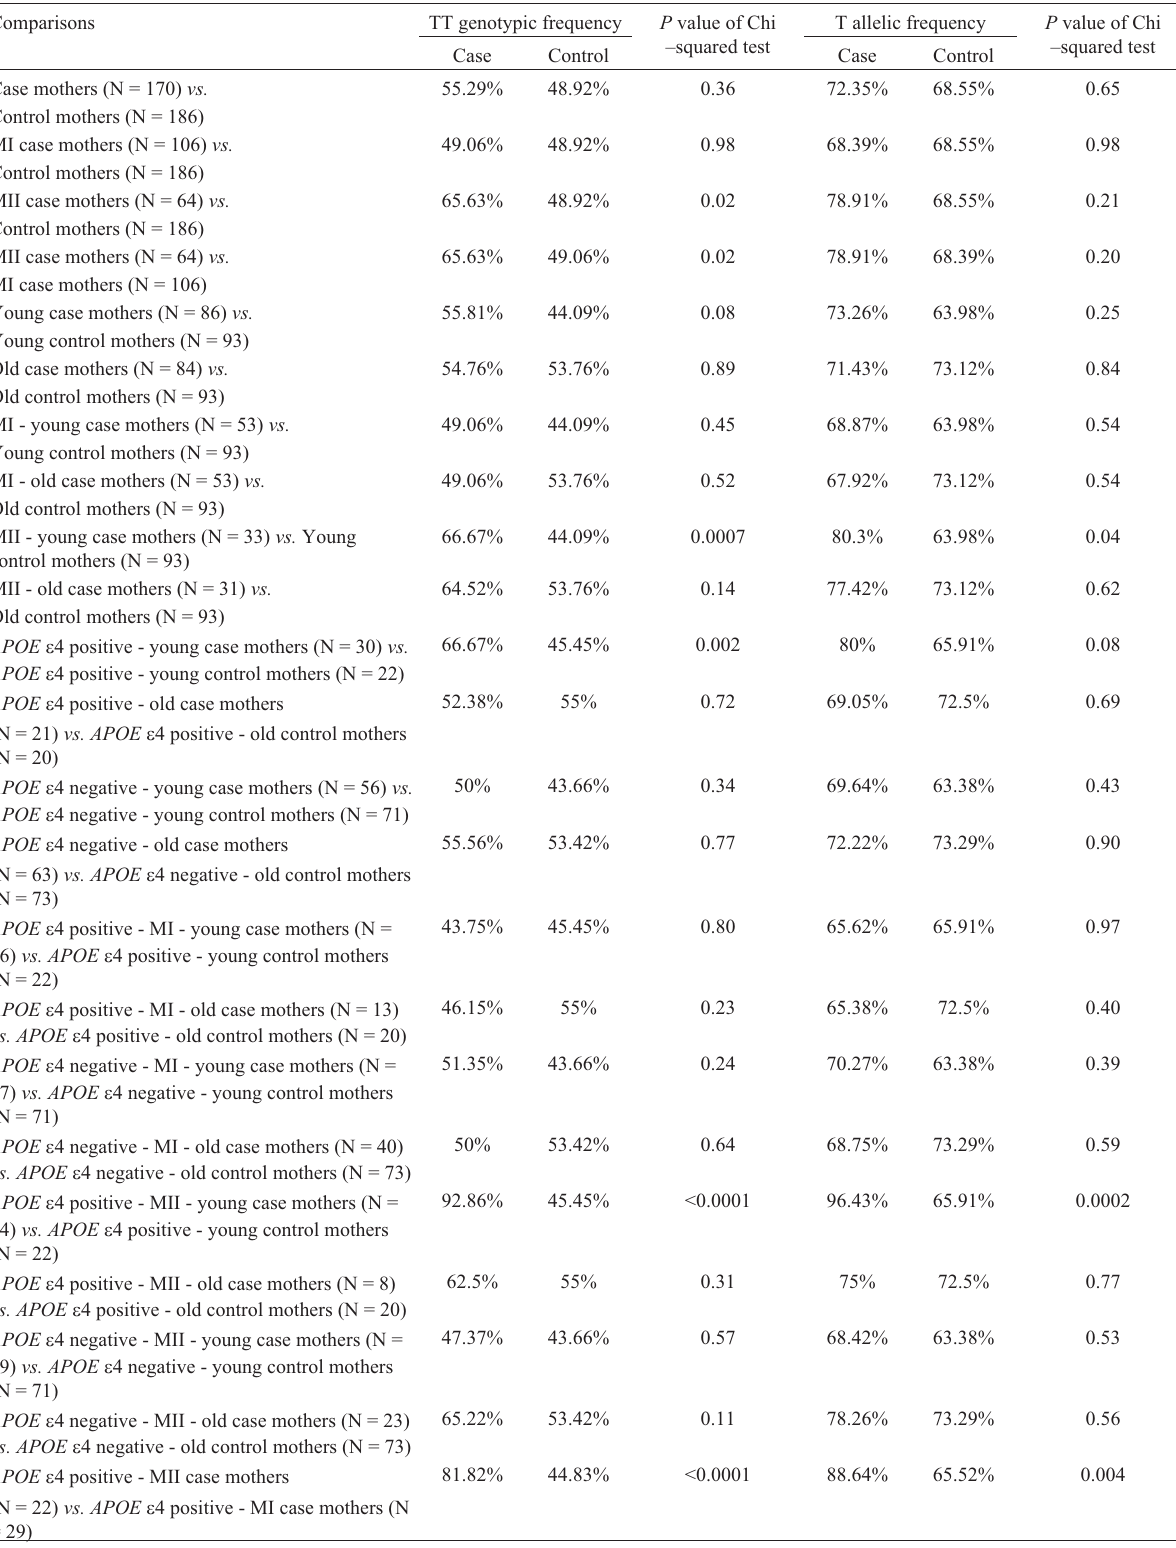
Table 1 - Comparison of PSEN-1 TT Genotypic and T allelic frequencies among different groups of mothers of DS children and control mothers of karyotypically normal children. Comparisons TT genotypic frequency P value of Chi